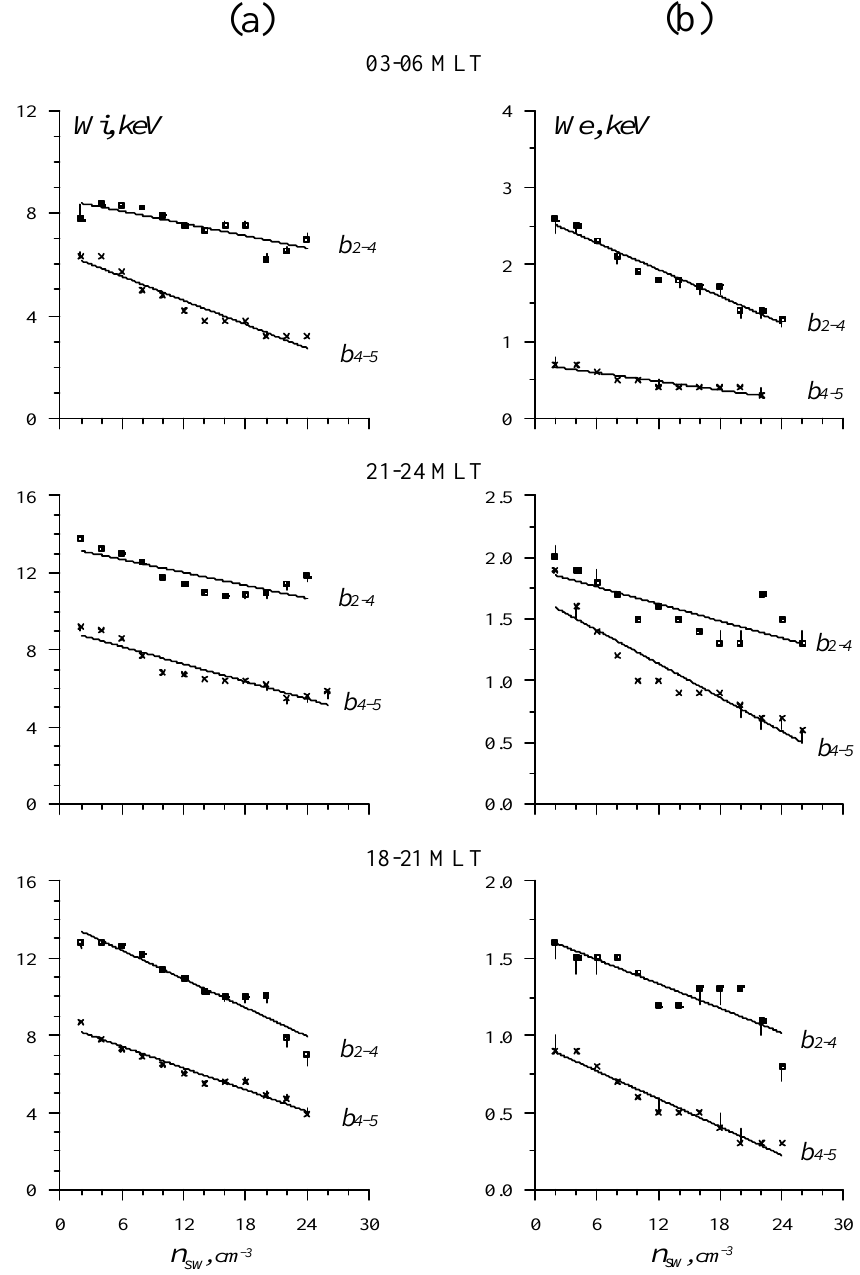
Fig. 2. Average ion (a) and electron (b) energy in the b 2 i – b 4 s and b 4 s – b 5 regions during periods of the IMF B z > 0 versus solar wind plasma